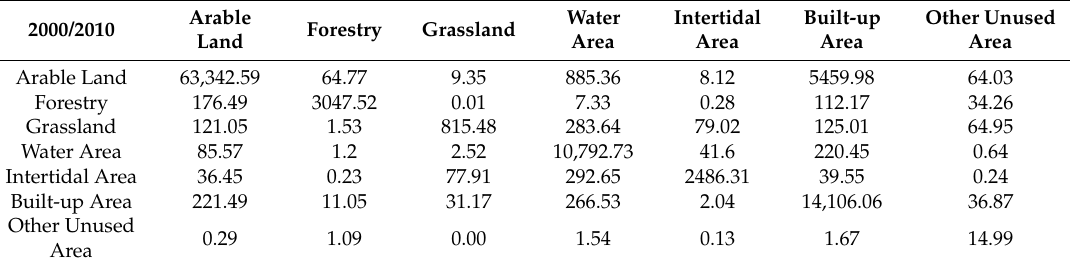
Table 4. Land use situation transition matrix in Jiangsu province from 2000 to 2010 (km 2 ).